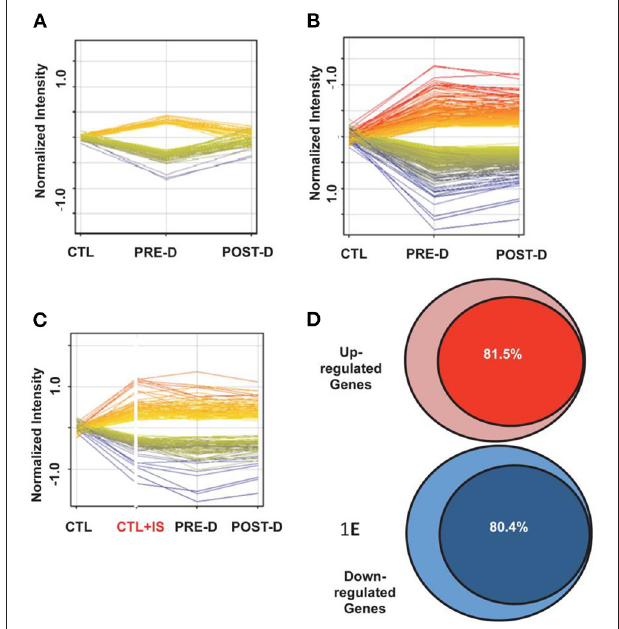
FIGURE 1 | Gene expression in reporter renal tubular cells. (A) Gene expression changes that returned to baseline post-dialysis. Each individual line represents the average value in the 10 uremic subjects for each gene that was dysregulated. The expression of 282 genes was upregulated (displayed as yellow to red lines) and the expression of 255 genes was downregulated (displayed as green to blue lines) in the pre-dialysis samples as compared to normal controls. Post-dialysis these values returned to baseline. (B) Gene expression that remained dysregulated after dialysis treatment. The expression of 843 genes was upregulated and the expression of 532 genes were downregulated. (C) Genes expressed following incubation in normal plasma spiked with indoxyl sulfate compared with their expression levels in cells treated with pre-dialysis and post-dialysis plasma. The expression of 908 genes was upregulated and the expression of 571 genes were downregulated. (D) 81.5% of upregulated genes that were not normalized by dialysis were mimicked by addition of indoxyl sulfate to normal plasma. (E) 80.4% of downregulated genes that were not normalized by dialysis were mimicked by addition of indoxyl sulfate to normal